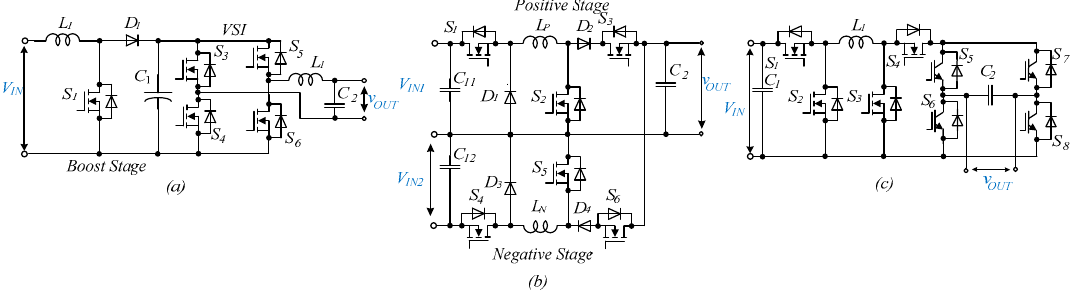
Figure 1. Conventional boost dc-dc converter along with voltage source inverter ( a ), Aalborg inverter ( b ), buck-boost inverter with unfolding circuit ( c ).